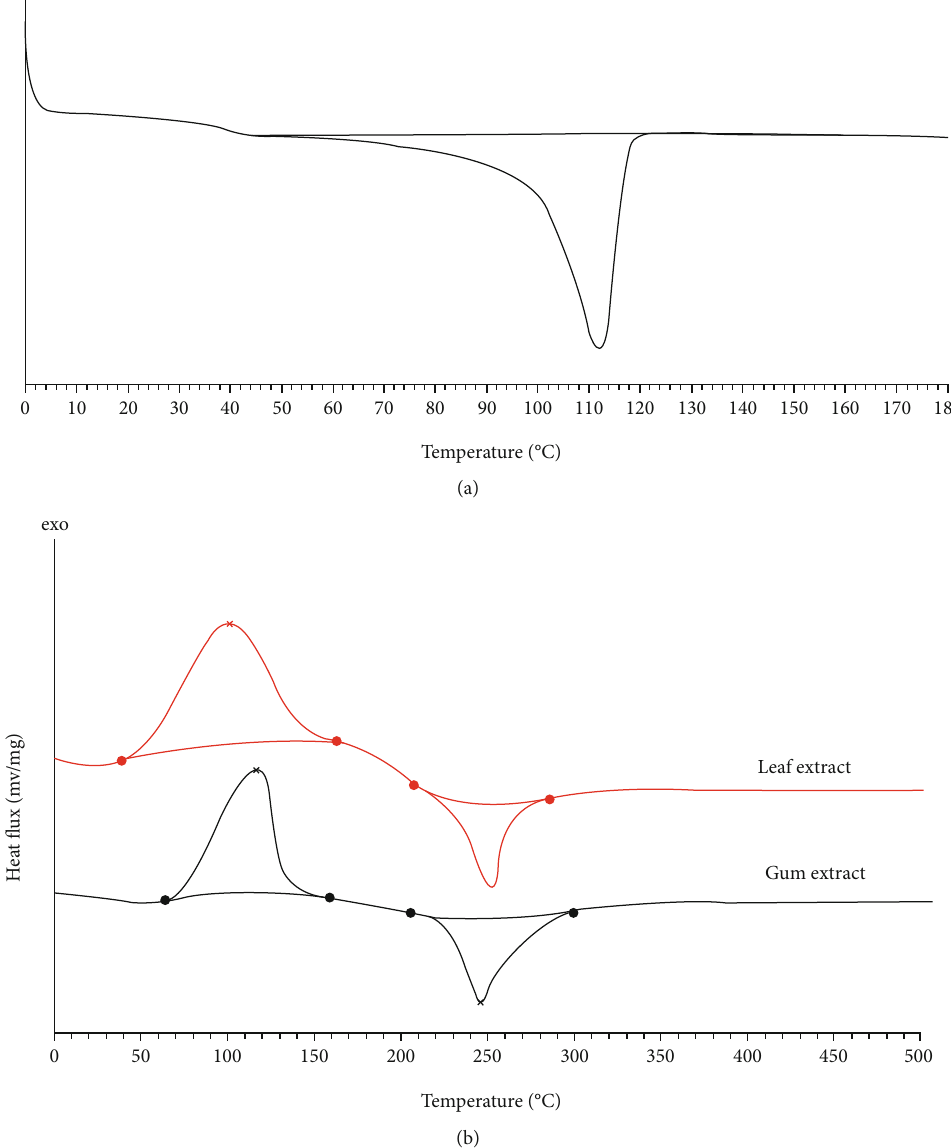
Figure 5: DSC thermograms: (a) polyethylene fi lm; (b) leaf and gum